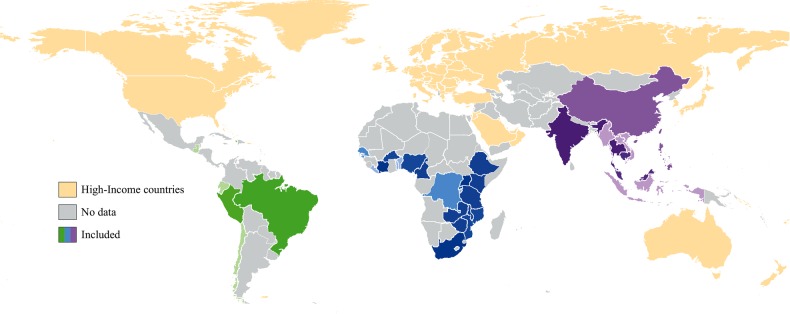
Low- and middle-income countries reporting the incidence of key opportunistic infections and antiretroviral therapy status. Thirty-eight countries provided included data. Green represents Latin America and the Caribbean, blue represents sub-Saharan Africa, and purple represents Asia. Color darkness reflects the number of included studies, with darker shading representing more studies. High-income countries were not eligible for inclusion.